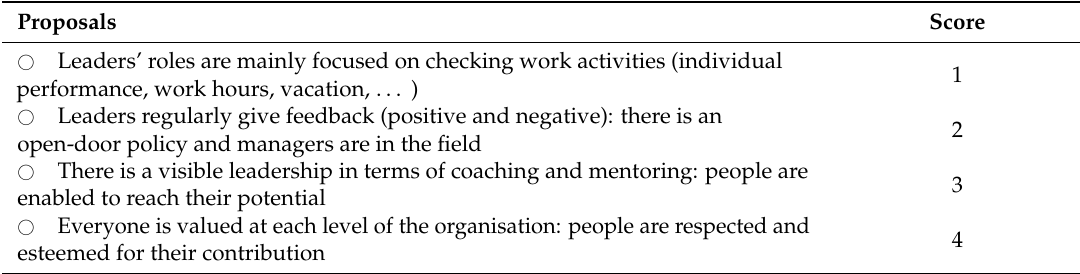
Table 2. Example of an assessment